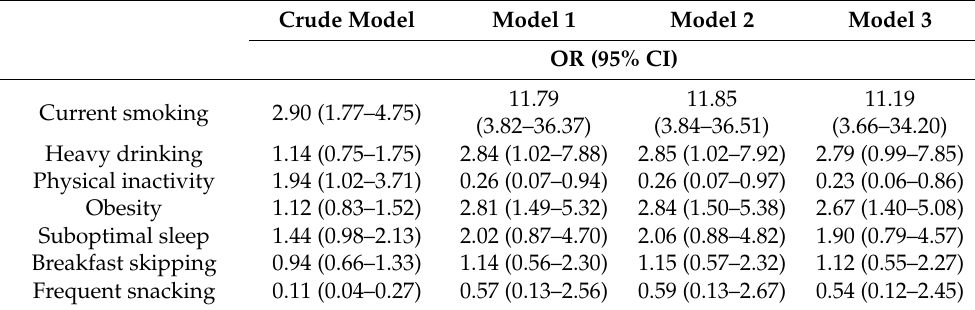
Table 2. Results of binary logistic regression analysis for predictors of high ASCVD score in cancer survivors.